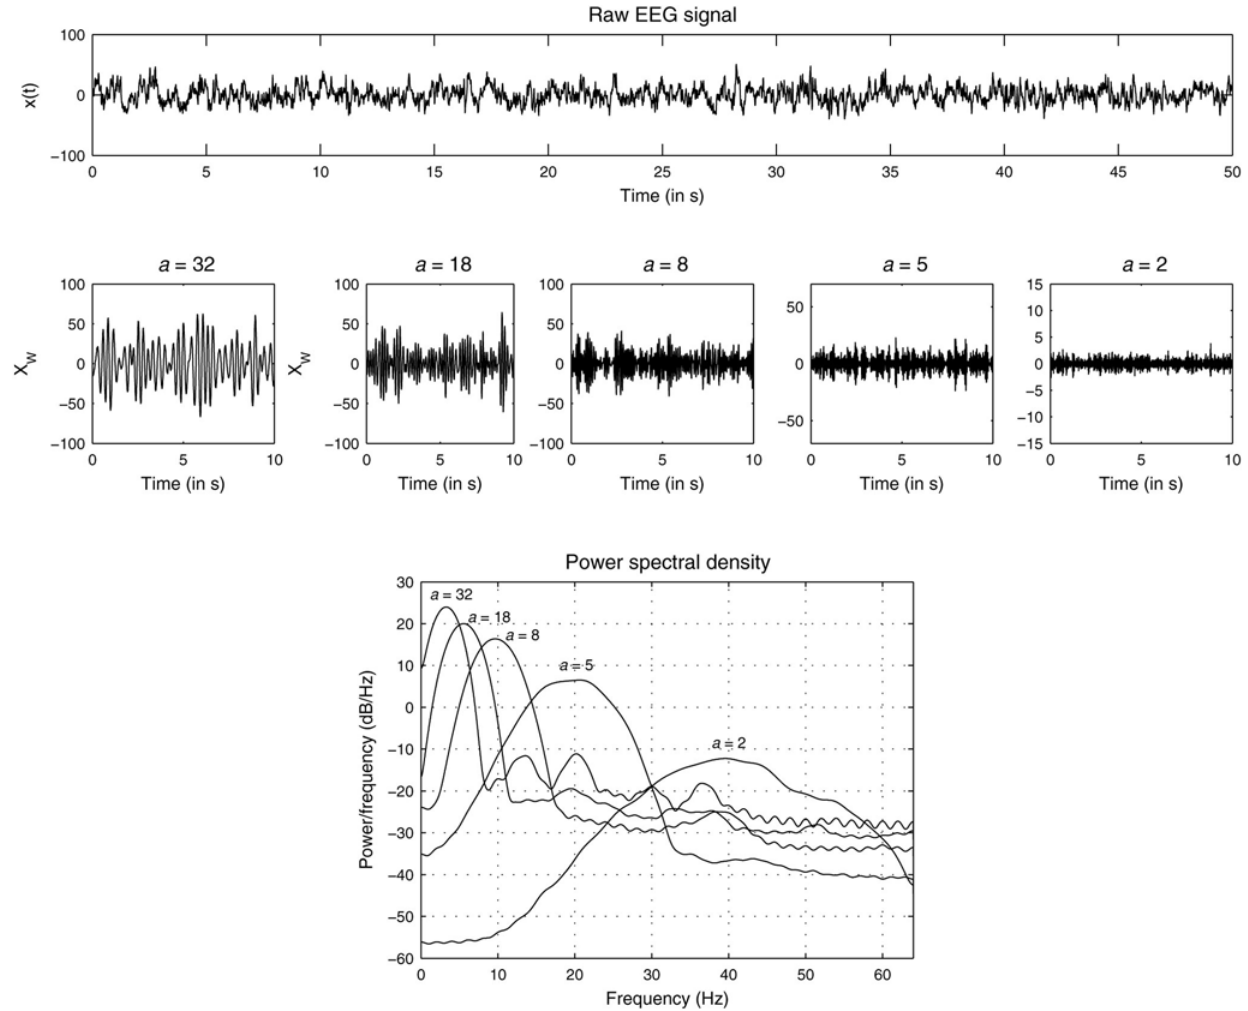
Figure 1. EEG and its (real) wavelet transformed components. Upper panel : Segment of electroencephalogram recorded at location Pz from a participant (Vp.483) while imagining an object of visual art shown earlier. Middle : Wavelet transform W x ( a , t ) of the signal shown above at five different scales a =32, 18, 10, 5, and 2, respectively. Lower: Power-spectral densities of the wavelet transformed signals.